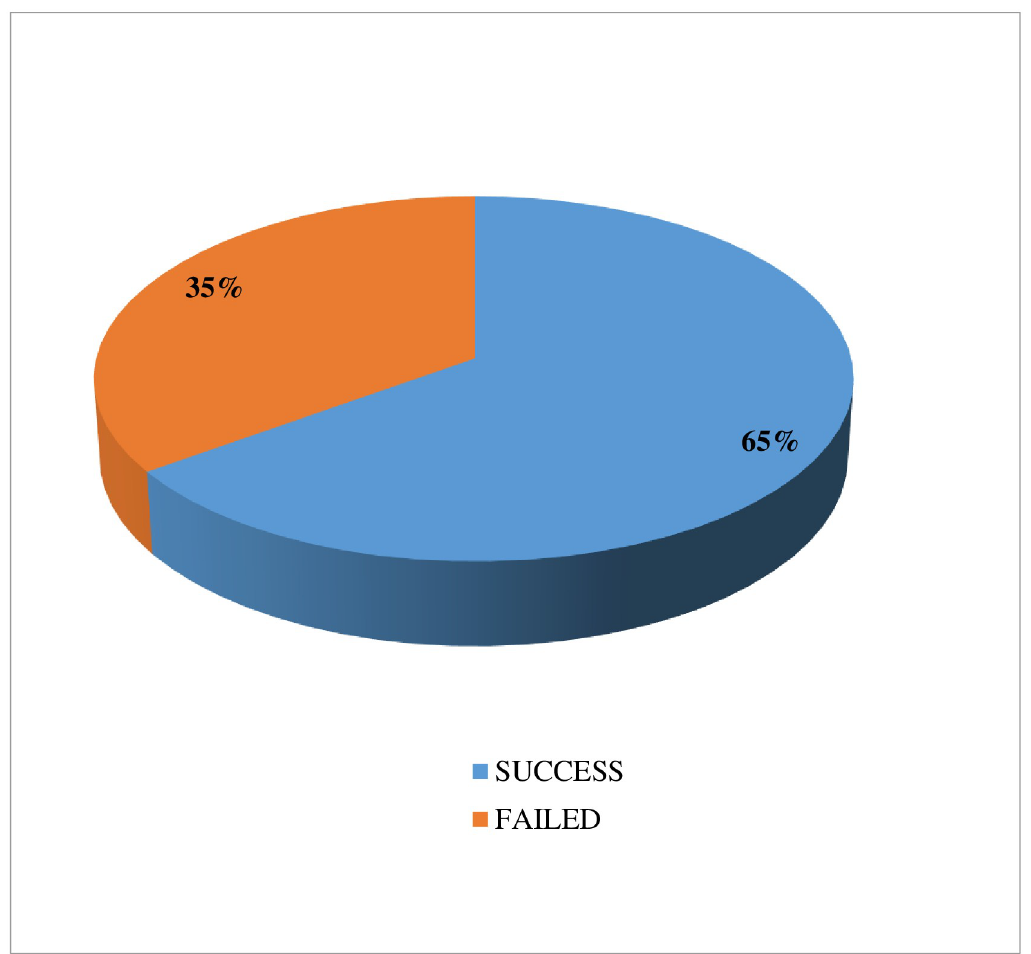
Fig 2. Magnitude of the outcomes after induction of labor among mothers who delivered after induction of labor in public Hospitals of Harar town, Eastern Ethiopia, 2019.